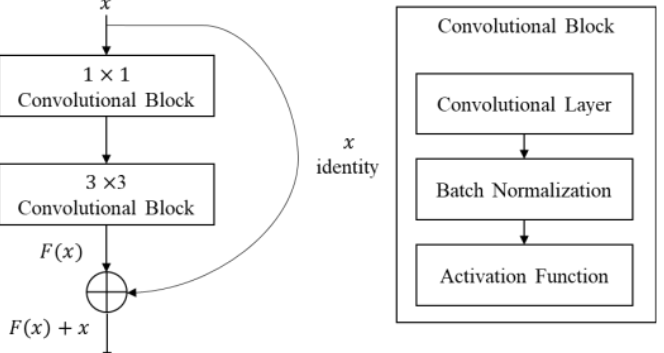
Figure 4. Residual block structure in YOLOv4.